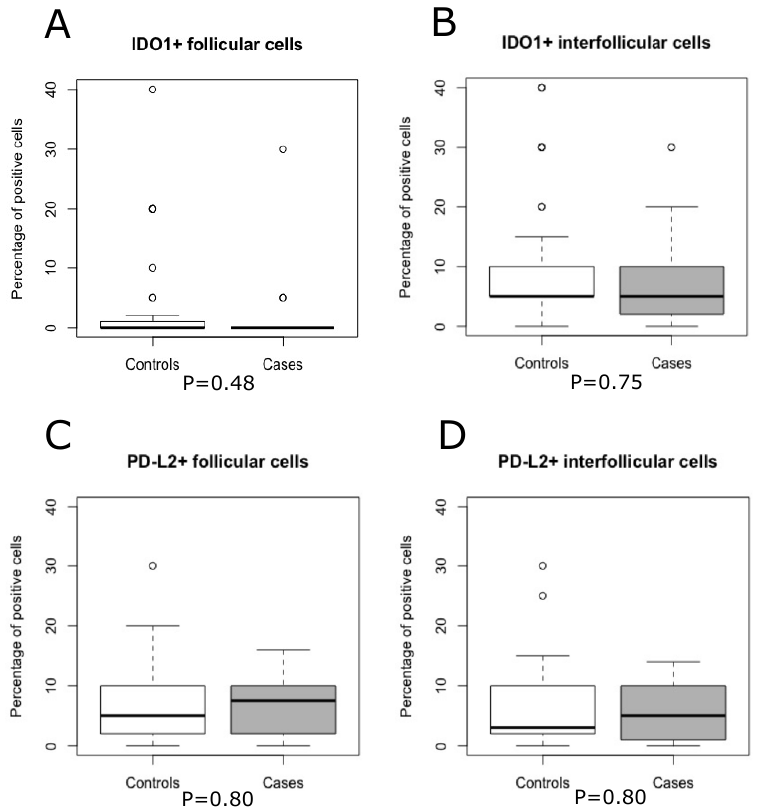
Figure 4. Boxplots of amounts of IDO1+ and PD-L2+ cells in patients with autoimmune diseases (cases) and without autoimmune diseases (controls). Mann–Whitney U-test based p values (cases compared with controls).